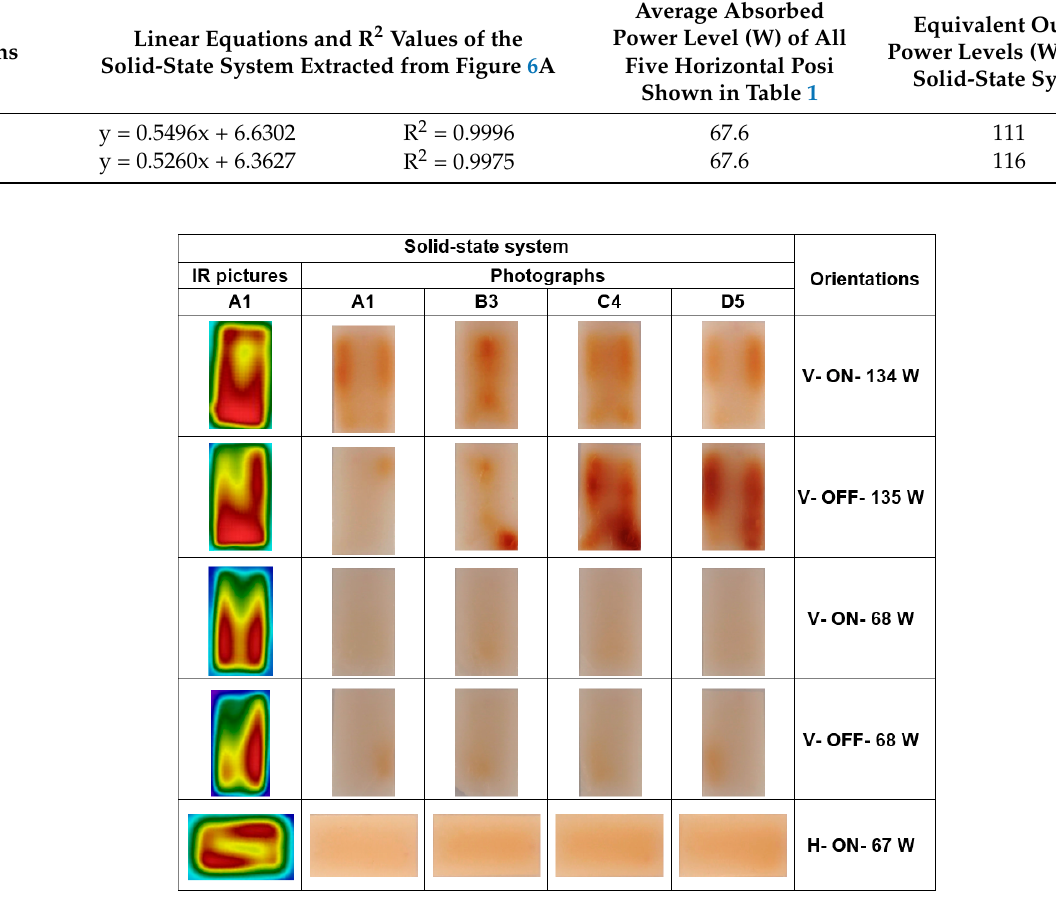
Figure 9. Photographs of sample surfaces A1, B3, C4, and D5 and the IR picture of surface A1 processed at vertical (V) and horizontal (H) orientations with (ON) and without (OFF) turntable rotation at different absorbed power levels after 120 s heat processing in the solid-state microwave systems.